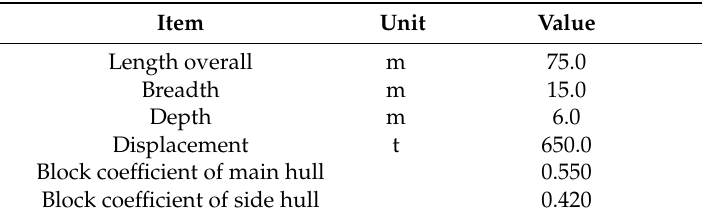
Table 1. The main d imensions of Table 1. The main dimensions of trimaran.